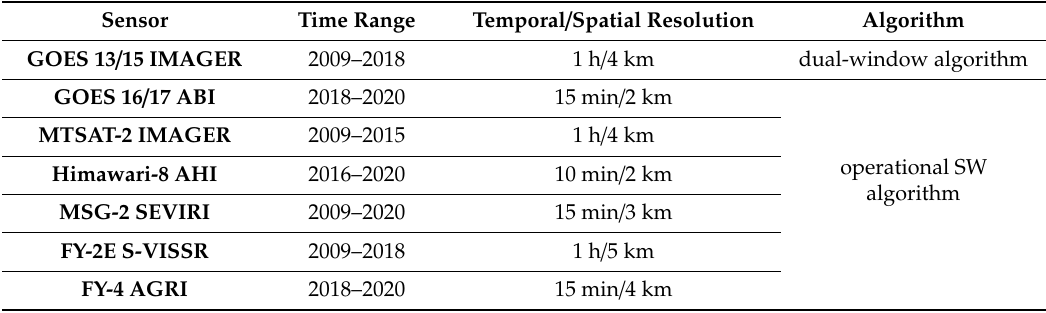
Table 12. Summary of satellites and algorithms used in generation of the global geostationary (GEO) LST